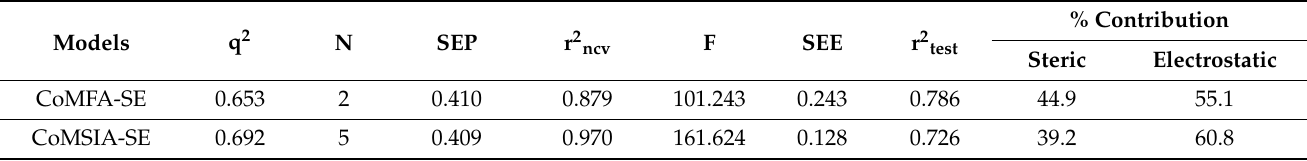
Table 5. Statistical summary of the best models for CoMFA and